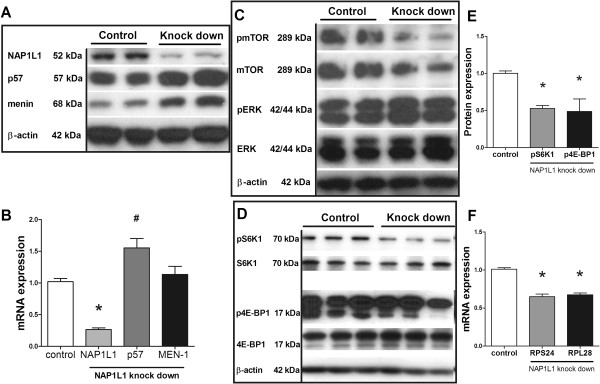
Effect of NAP1L1 silencing. Effect of NAP1L1 silencing on p57Kip2 and menin expression as well as on the mTOR pathway in BON cells. An effective NAP1L1 knockdown (approximately 3-fold, *p < 0.001) increased p57Kip2 protein (A) and mRNA (B) (#p < 0.01), while menin was increased at protein level only (A and B). The ERK pathway was unaffected in NAP1L1-silenced cells, while total mTOR as well as phosphorylated mTOR decreased in NAP1L1 silenced BON cells (C). The mTOR downstream effectors eukaryotic initiation factor 4E-binding protein (4E-BP1) and S6 kinase (S6K1) also showed less protein expression and decreased phosphorylation when NAP1L1 was absent (D and E) (*p < 0.05). MRNA levels of the two ribosomal proteins RPS24 and RPL28, as a measure of mTOR activity, were also decreased in NAP1L1 knockdown cells (*p < 0.05), indicating that NAP1L1 may promote mTOR signaling (F). 4E-BP1, lower band. Mean ± standard error of mean (SEM).